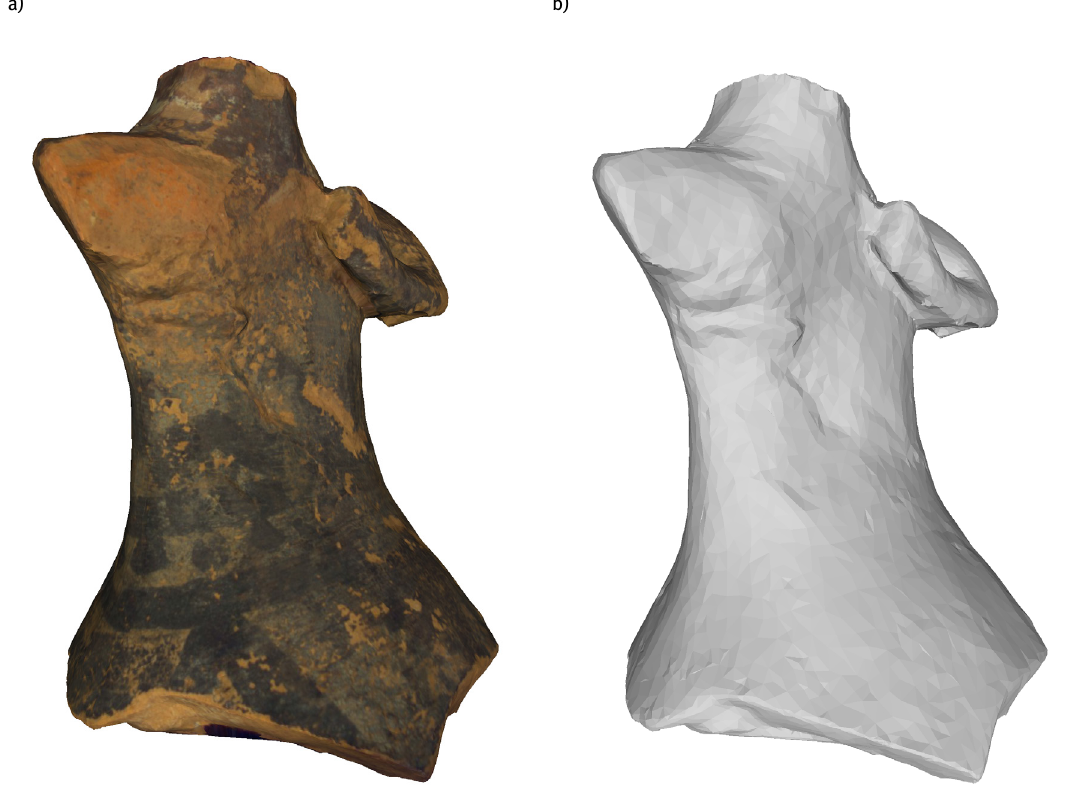
Figure 3. Example to show scanned model with photorealistic surface (3a) and plain modelled surface (3b). Worn torso frag- ment from Petsofas (University College Dublin, Classical